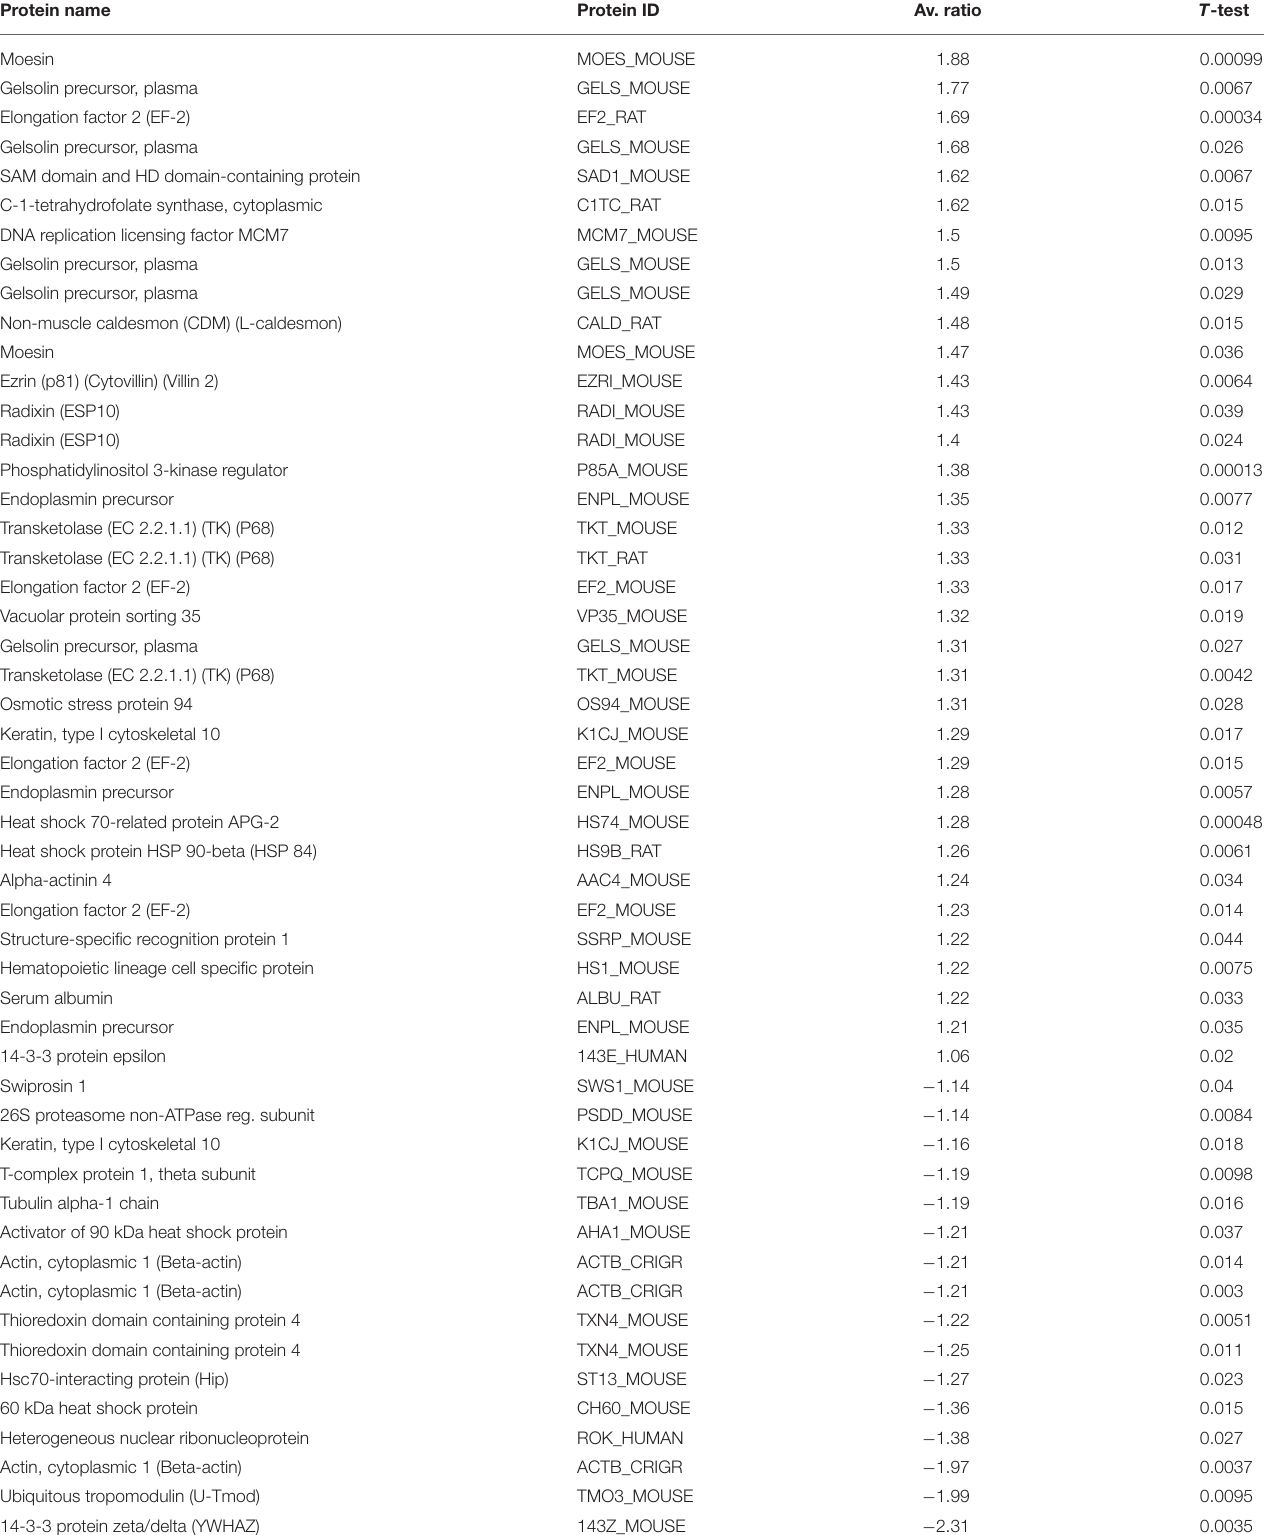
TABLE 2 | Protein expression changes in mouse spleen after mice were exposed to 5mM kynurenine in drinking water for